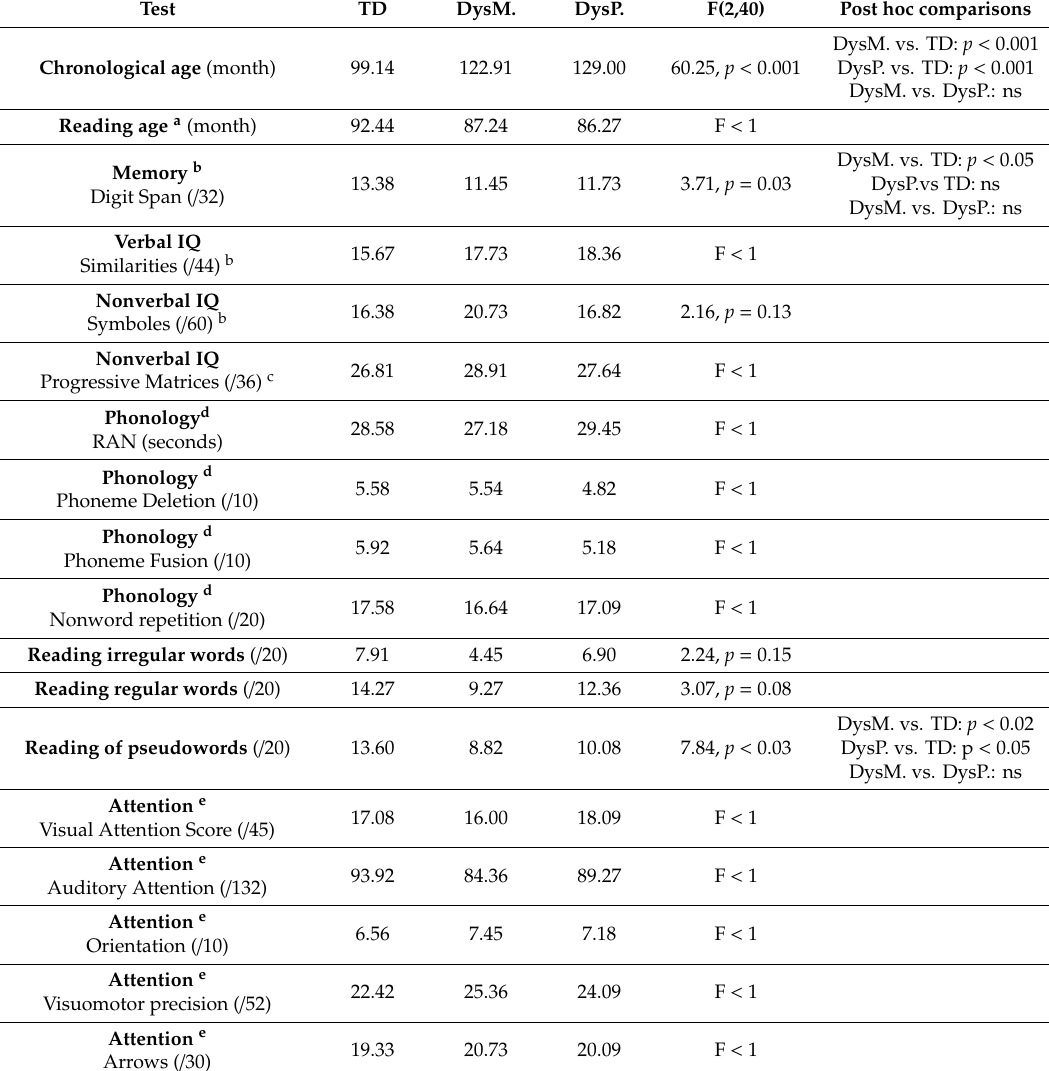
Table 1. Before training. Results of children with dyslexia (DysMus and DysPaint) and of typically developing readers (TD) who were matched on reading age, on measures of memory, on verbal and nonverbal intelligence, on phonology, on reading regular words, irregular words and pseudo-words, and on visual and auditory attention. For each test, the number in brackets (e.g., / 44) corresponds to maximum